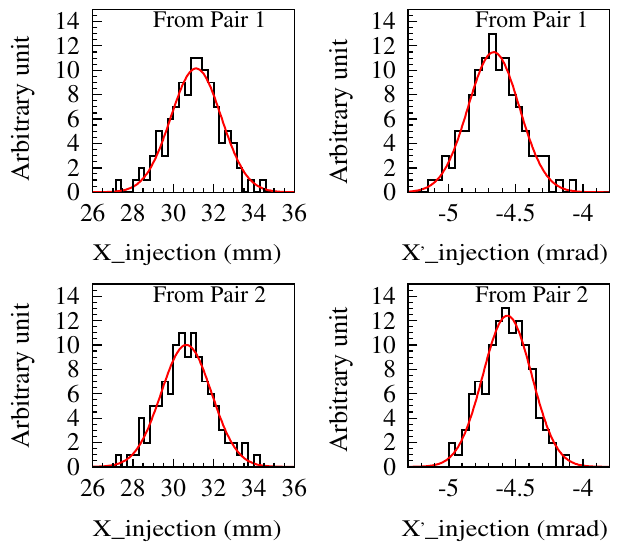
FIG. 9. (Color) The overall error of the result obtained using the present method was estimated by repeating measurements (paint bump with constant at the top for a painting area of 100 (cid:1) mm mrad , refer to Table I) 111 times. The phase space coordinates at the injection point were obtained using Eq. (13) for each measurement and plotted as histograms. The upper two figures represent the results obtained using data from pair 1, whereas the lower two figures are for those obtained using data from pair 2. The mean value and the width were obtained by fitting each distribution to a Gaussian function (solid red lines). The mean value of X and X 0 from pair 1 were then found to be 31.1 mm and (cid:2) 4 : 66 mrad , respectively, while those from pair 2 were found to be 30.7 mm and (cid:2) 4 : 52 mrad , respectively. The rms widths from each pair were exactly the same at 1.2 mm and 0.19 mrad for c, respectively. The mean values of the results from both pairs were thus found consistent using the single measure- ment presented in Table I, where the overall error in rms for the reconstruction of the painting injection footprint can be consid- ered to be (cid:7) 1 : 2 mm and (cid:7) 0 : 19 mrad for X and X 0 ,